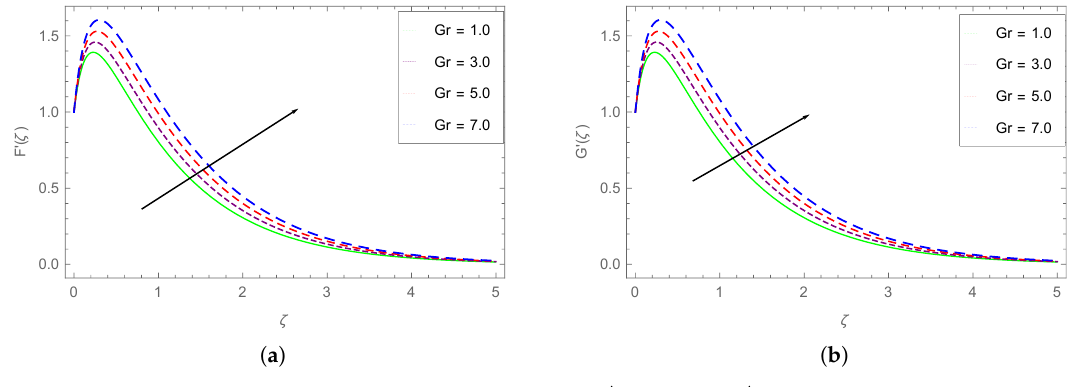
Figure 11. Impact of Gr on ( a ) F (cid:48) ( ζ ) and ( b ) G (cid:48) ( ζ ) .